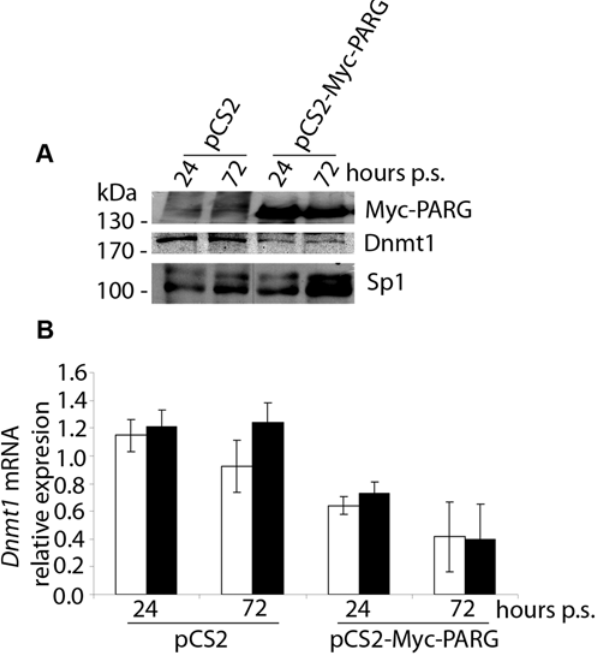
Figure 2. Ectopic over-expression of PARG leads to down- regulation of Dnmt1 expression. A, Nuclear lysates from cultures transfected with pCS2 and pCS2-Myc-PARG vectors at 24 and 72 hours of puromycin selection were analyzed by SDS-PAGE and Western blot using anti-Myc epitope and anti-Dnmt1 antibodies; anti-Sp1 antibodies served as endogenous control. B, Real time RT-PCR for Dnmt1 performed on RNA samples from cell cultures transfected with pCS2 and pCS2-Myc-PARG vectors at 24 and 72 hours of puromycin selection. Gapdh (white bar) and Hprt1 (black bar) mRNAs were used as endogenous controls. Data are reported as mean 6 S.E. of the ratio of Dnmt1 mRNA level to Gapdh or Hprt1 mRNA level within each sample, calculated from a minimum of three experiments performed in duplicate.